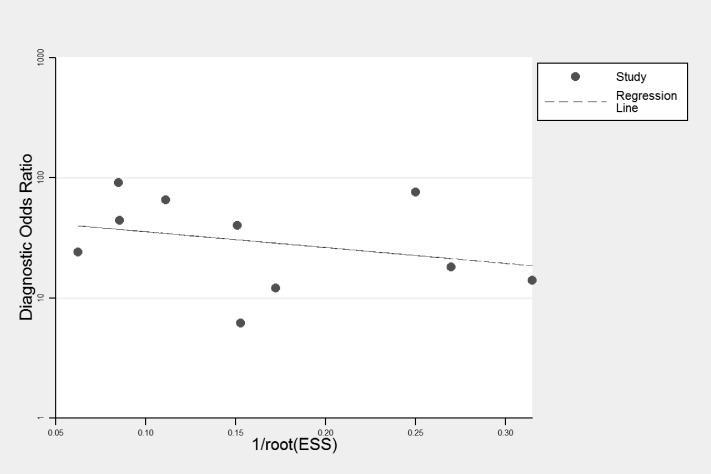
Deeks’ funnel plots for publication bias.